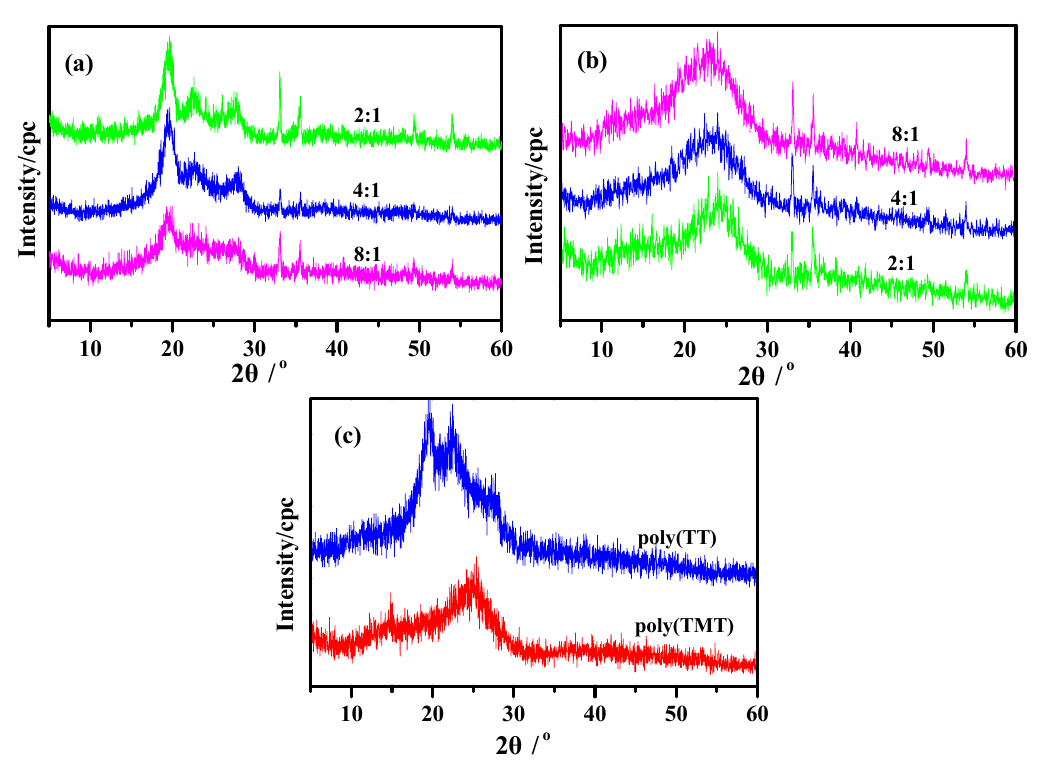
Figure 4. XRD of polymers: ( a ) poly(TT)s; ( b ) poly(TMT)s; [FeCl